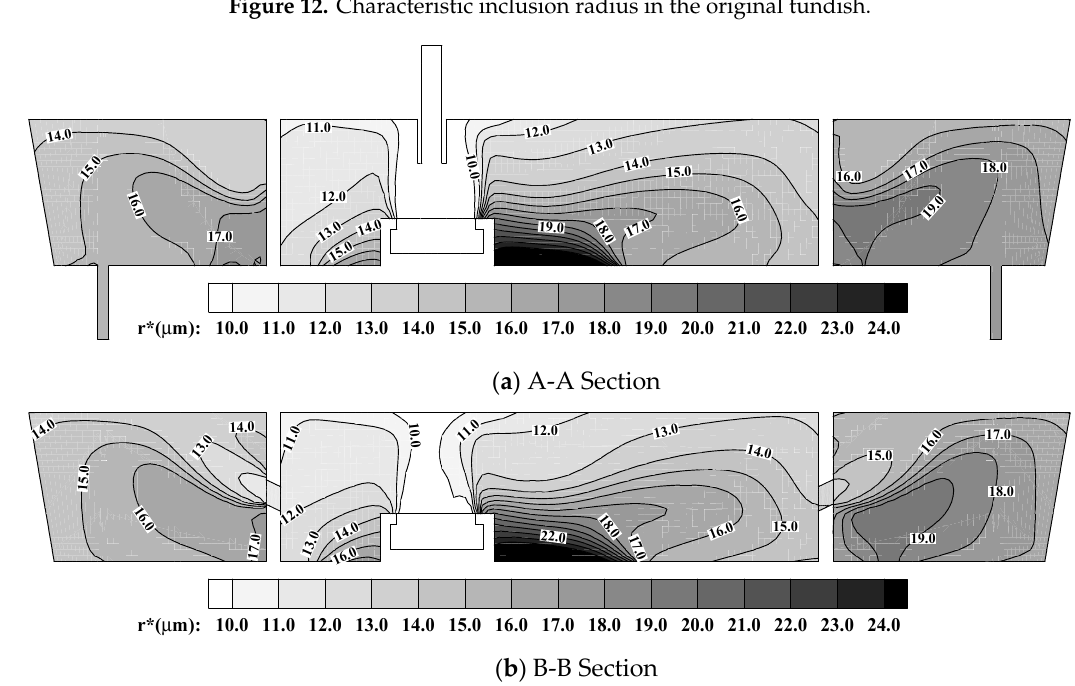
Figure 13. Characteristic inclusion radius in the optimized tundish.